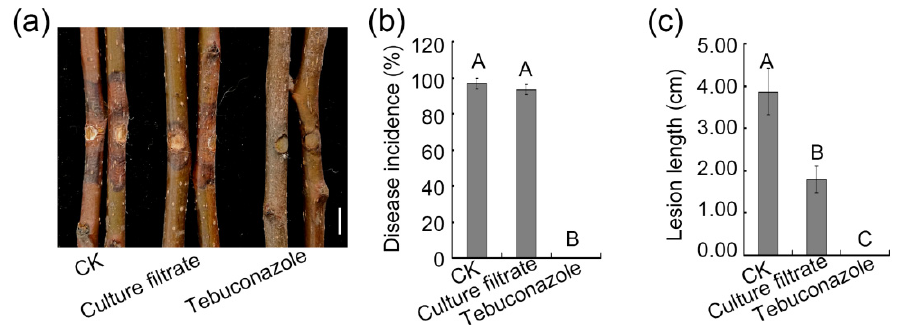
Figure 6. Effect of culture filtrate of ZZ1 on pear Valsa canker disease caused by V. pyri . ( a ) Culture filtrate of ZZ1 could antagonize pear Valsa canker. Bar, 1 cm. The picture was taken at 7 days after inoculation. ( b ) Statistical analysis of the disease incidence. ( c ) Statistical analysis of disease lesion length. Values are means ± SD from ten replicates. Letters above the bars indicate statistical significance ( p < 0.01) based on Tukey’s test.